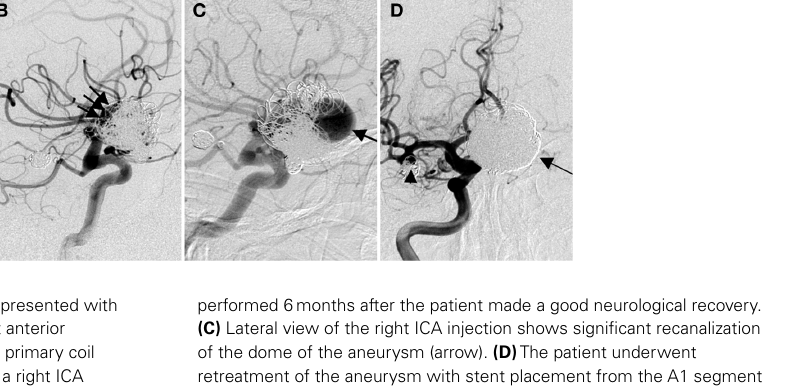
FIGURE 2 | Recanalized aneurysm. A 59-year-old man presented with SAH found to have multiple aneurysms including a giant anterior communicating artery (ACoA) aneurysm. He underwent primary coil embolization initially. (A) Anterior–posterior (AP) view of a right ICA injection shows coil mass in the giant aneurysm (arrow).There is still some residual filling of the aneurysm. (B) Lateral view shows the residual aneurysm more clearly (arrows).The anterior cerebral arteries (ACA) were difficult to separate from the aneurysm on the angiogram, and the aneurysm was underpacked in order to preserve these arteries. Follow-up angiography was